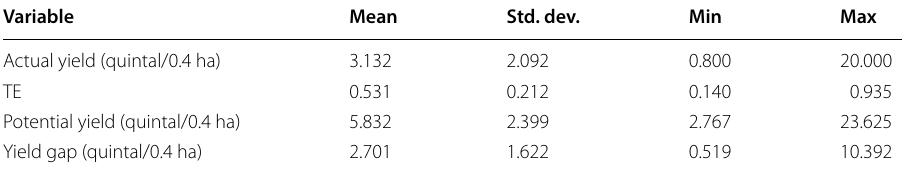
Table 2 Black cumin yield gap due to technical inefficiency Variable Mean Std. dev. Max Actual yield (quintal/0.4 ha) TE Potential yield (quintal/0.4